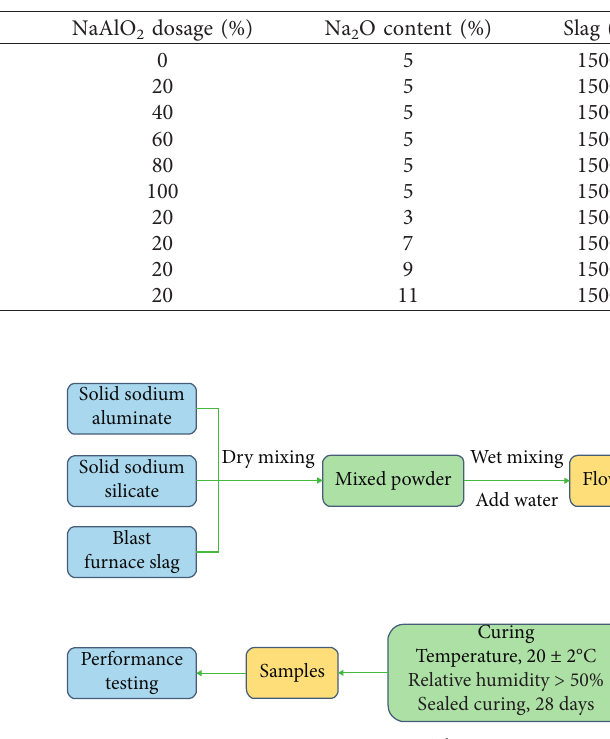
Table 2: Mixture proportions summary.